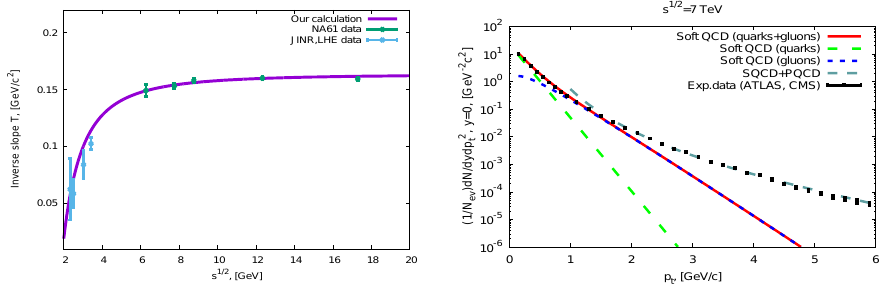
Figure 2. Left: the inverse slope parameter T for the reaction pp − > π − X calculated using Eq. 16. √ s < 18 GeV are the NA61 data [12], the points at 2 GeV < The points at 6 GeV < data extracted from [13, 14]. Right: results of the calculations of the inclusive cross section of charge hadrons produced in pp collisions at the LHC energies as a function of their transverse momentum p t √ s = 7 TeV. The points are the LHC experimental data [15, at